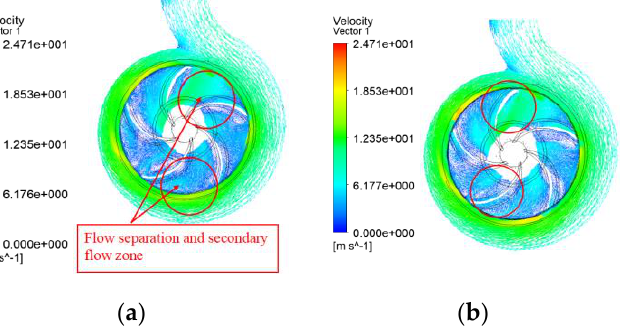
Figure 11. Velocity vector of flow region at 1000 rpm. ( a ) Original model; ( b ) rounded model.